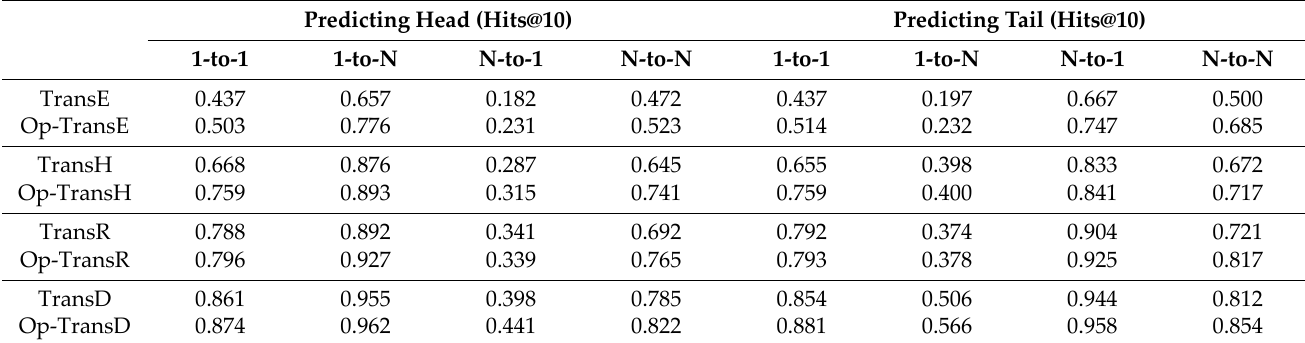
Table 9. Detailed results on FB15K in terms of different relation